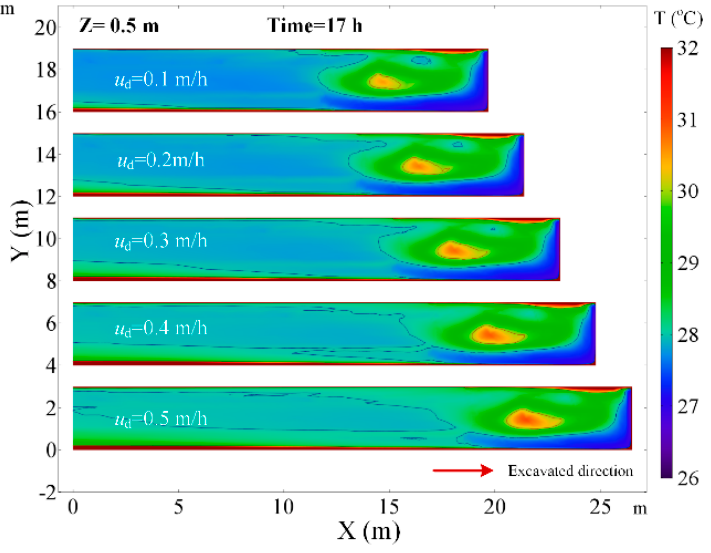
Figure 14. Air temperature distribution in Z = 0.5 m plane under different advance rate of the working face.